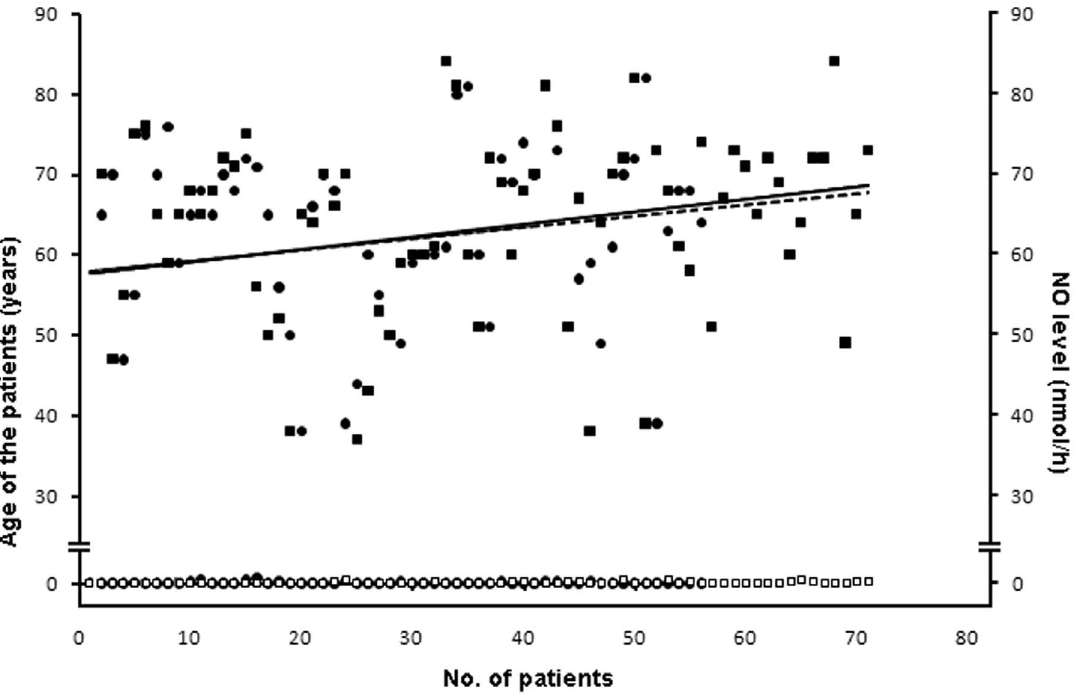
Figure 3. The age group-plasma NO level adjusted regression model in both Indian and Australian AMI patients. Regression model of the age related to the plasma NO level in both the Indian and Australian AMI patients was plotted. The age and the corresponding plasma NO level of N the participants could be determined from the plot. Solid line represents the regression curve of the age group of the Indian AMI patients. Dotted line ) indicate variations in the age group of Indian AMI indicates the regression curve of the age group of the Australian AMI patients. Solid circles ( patients. Solid squares ( & ) indicate variations in the age group of the Australian AMI patients. The hollow circles ( # ) and the hollow squares ( % ) represent the plasma NO level in Indian and Australian patients respectively.